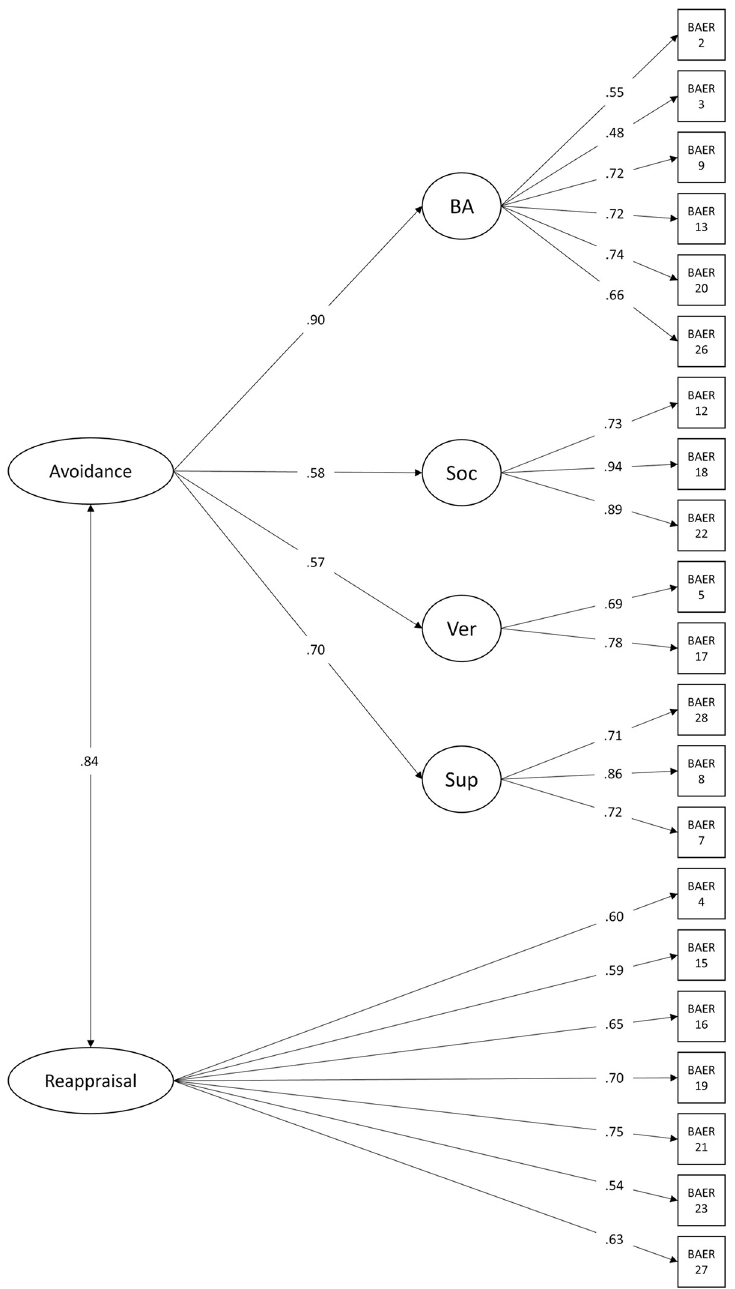
Fig 1. Results of the second order confirmatory factor analysis. All arrows show significant associations, p < .001; BA: Behavioural Avoidance, Soc: Social Reassurance, Ver: Verbal Reassurance, Sup: Suppression.